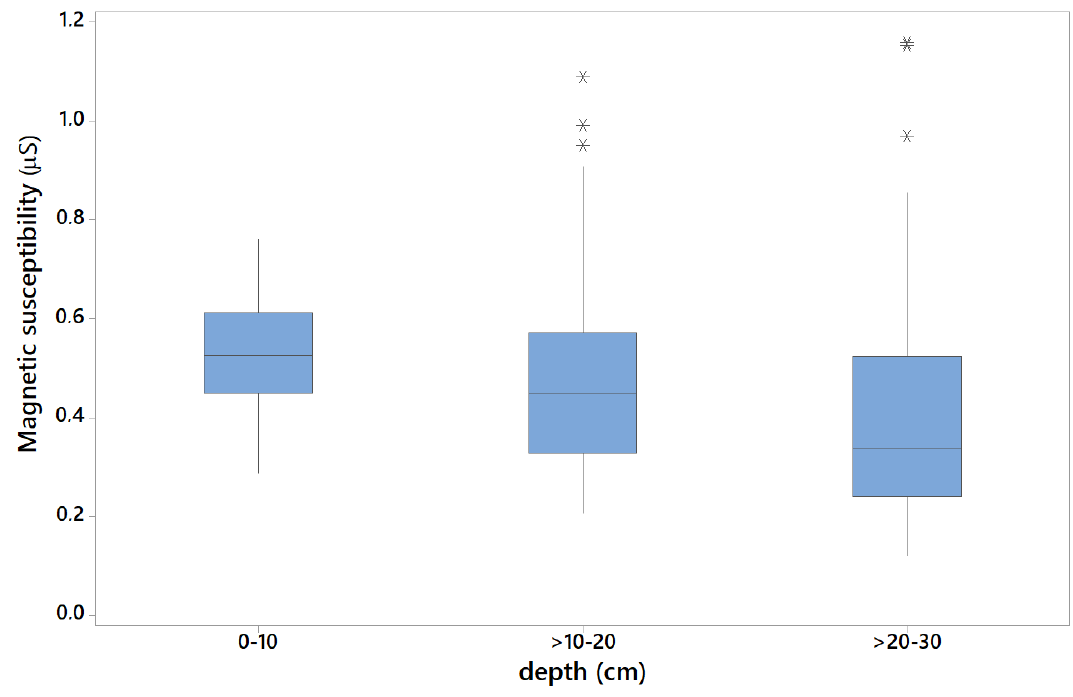
Figure 2. Boxplots for magnetic susceptibility (MS) values at three sampling depths. Minerals 2020 , 10 , x FOR PEER REVIEW